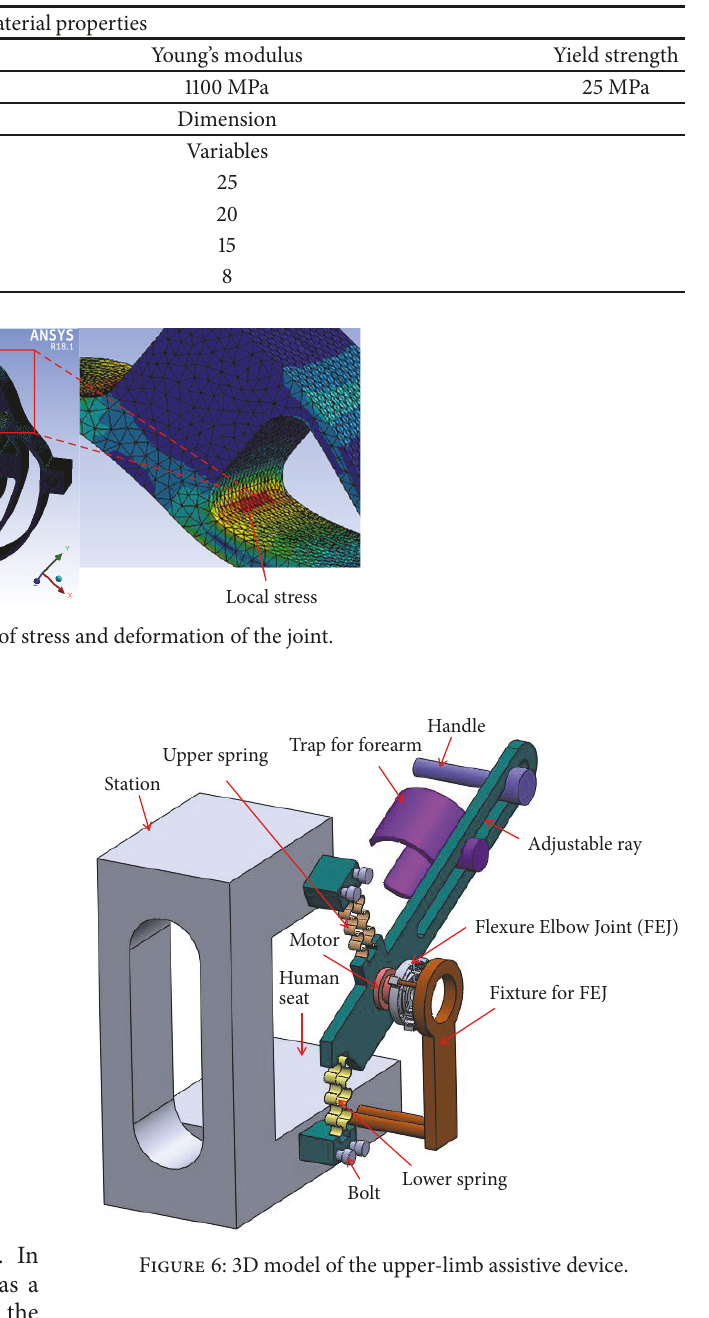
Table 1: Material polyethylene properties of the joint.